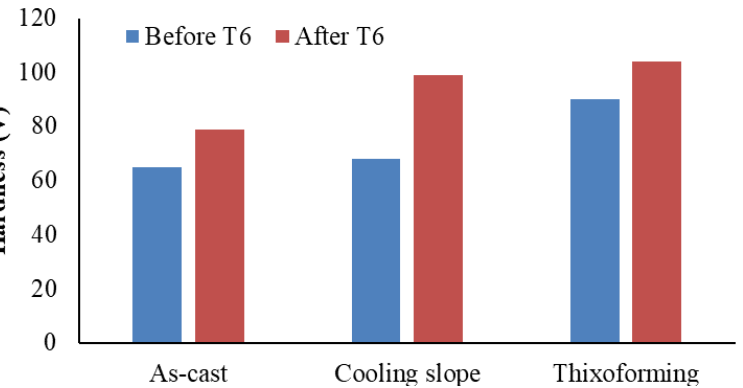
Figure 7. Microhardness of as-cast, cooling slope and thixoformed Al–7Si alloy before and after T6. Table 2. Average of microhardness.